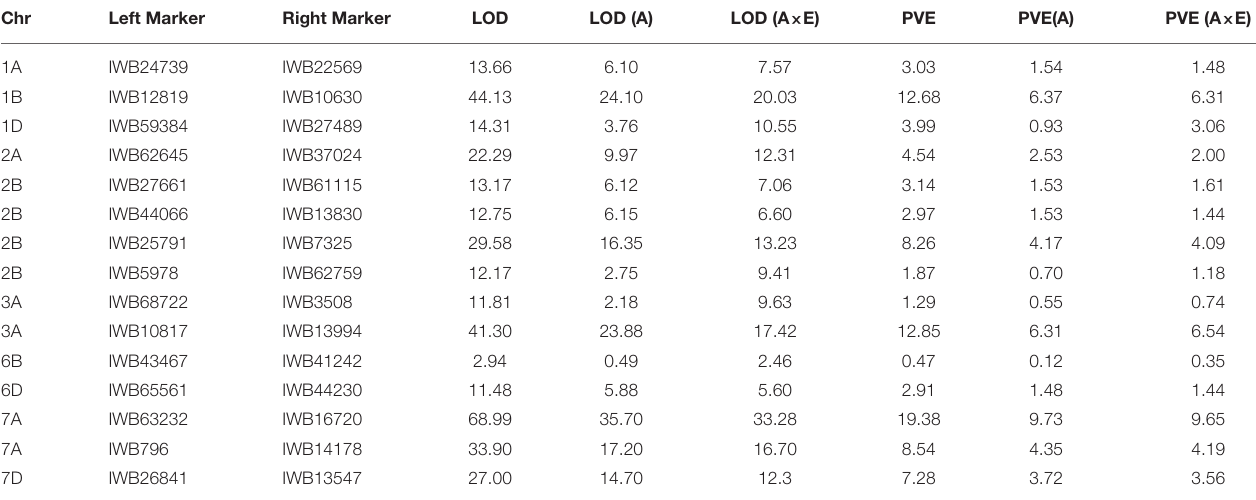
TABLE 5 | Summary of 15 stripe rust resistance QTLs discovered using the MET for the RIL population from the cross of Mingxian 169 × Pindong 34 tested in Mianyang and Yangling in 2016–2020. Chr Left Marker